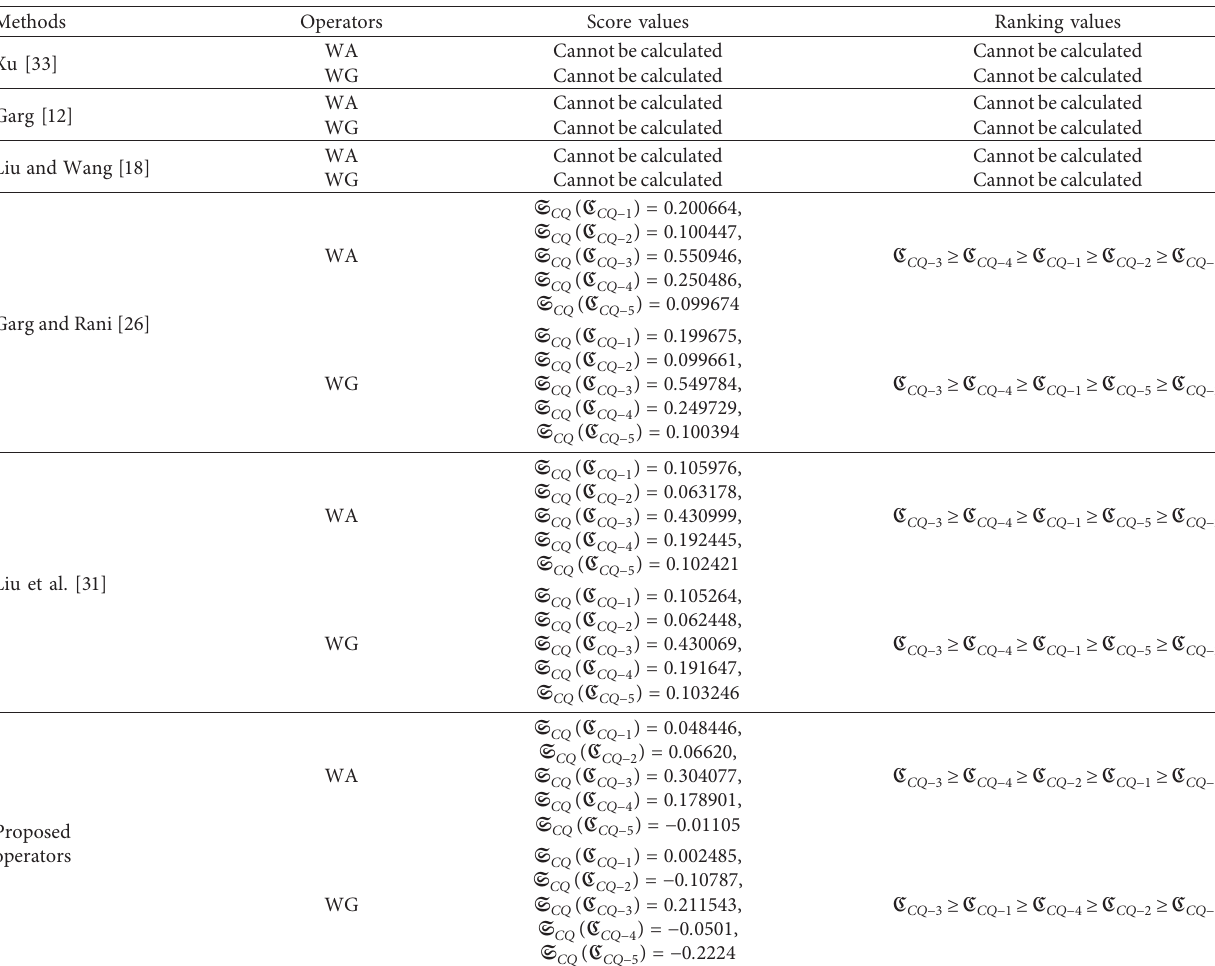
Table 9: Comparative analysis for the information of Table 5 corresponding to Example